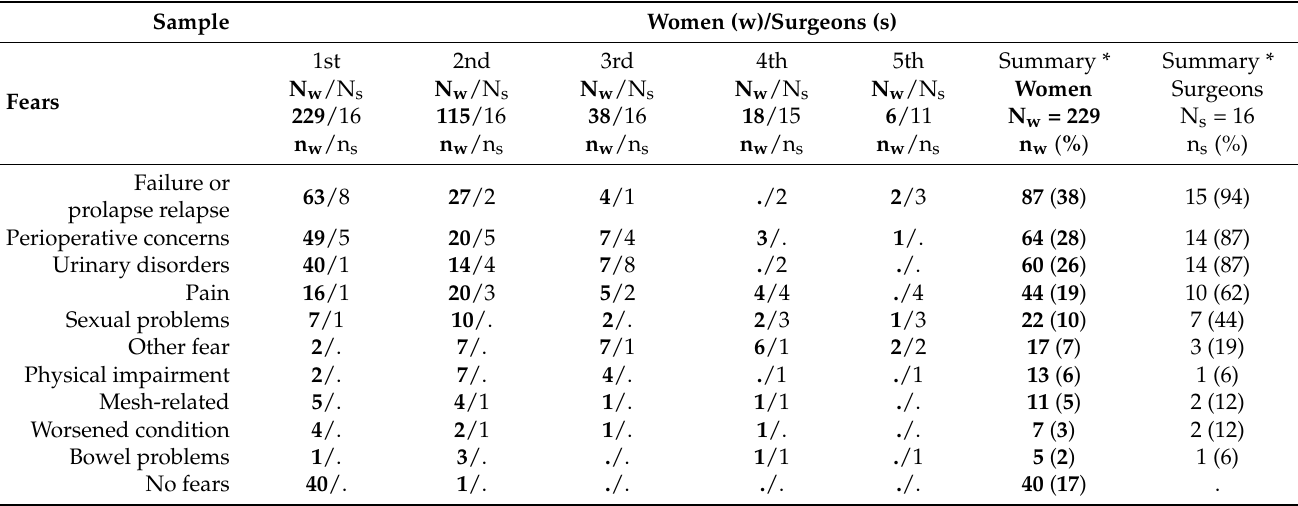
Table 4. Preoperative fears reported by women and surgeon (for a “typical”